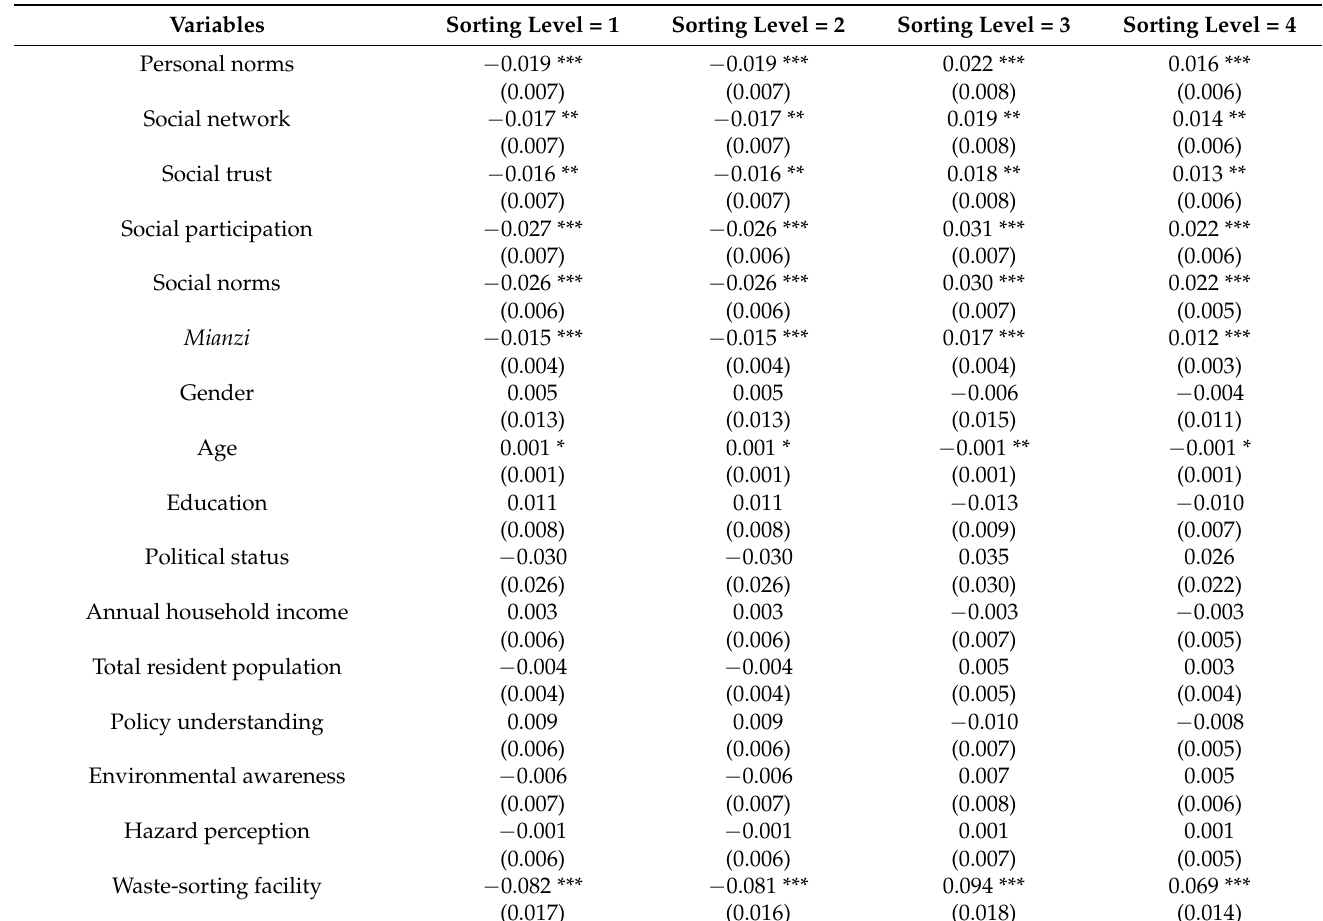
Table 4. Marginal effect of Ordered Probit